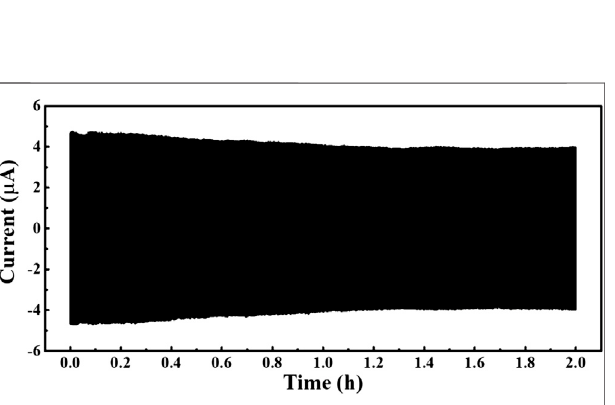
FIGURE 3 | Output current ofthe D-TENG working continuously for 2